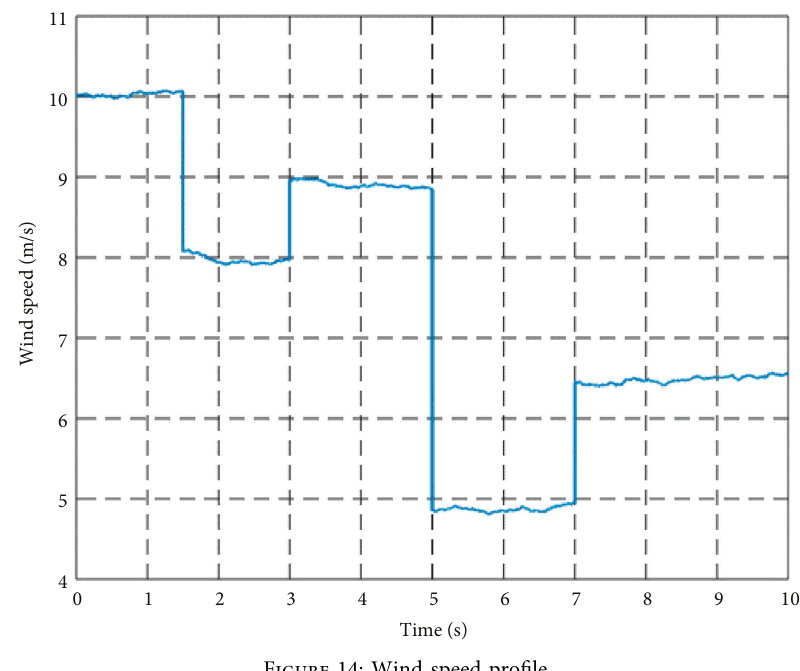
Figure 14: Wind speed profile.